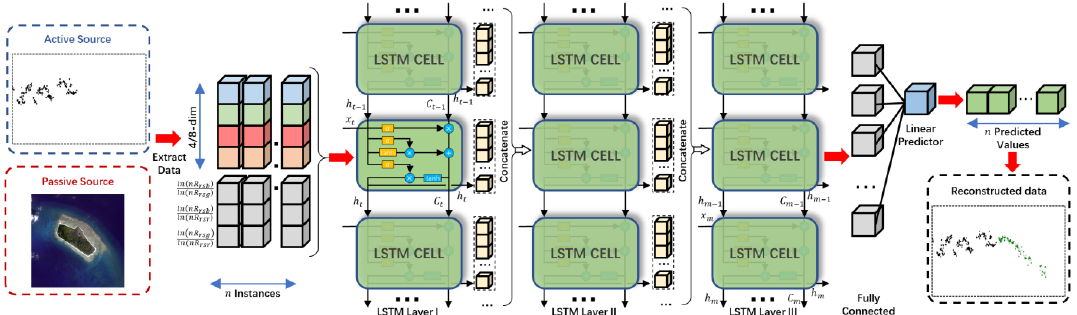
Figure 4. Diagram of the model architecture in this paper. The input is the active – passive data fu- sion and its log-ratio features, and the output is the reconstructed data along the ICESat-2 track.